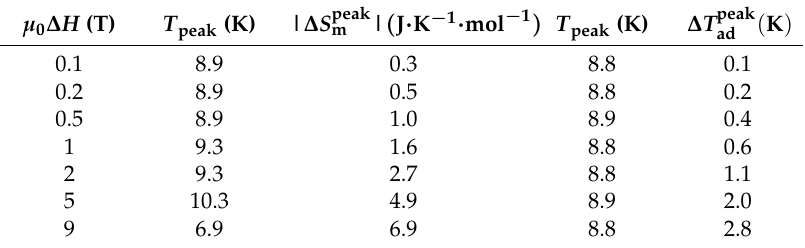
Figure 17. Temperature dependence of exponent n for 3 .